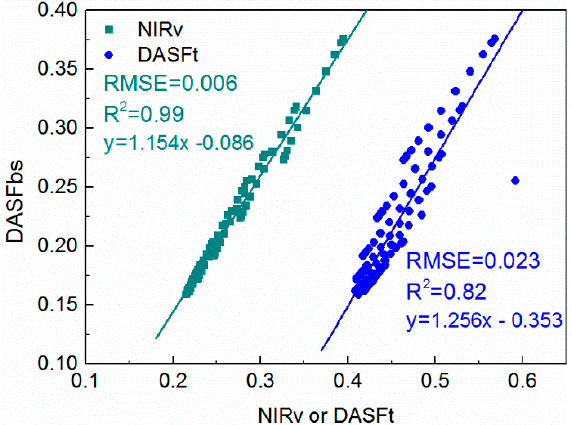
Figure 6. The polar map of NIRv, ( a ) the directional area scattering factor (DASF) calculated without the removal of the soil ( b ), and DASF calculated after the removal of the soil ( c ). The LAI is 1, LAD is erectophile, and the solar zenith angle is 30°. The other input parameters are the same as Table 1.